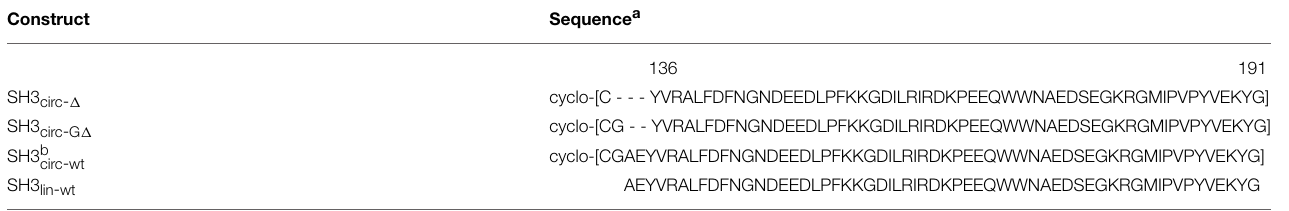
TABLE 1 | Amino acid sequence and notations for the various SH3 domain constructs used in this study.